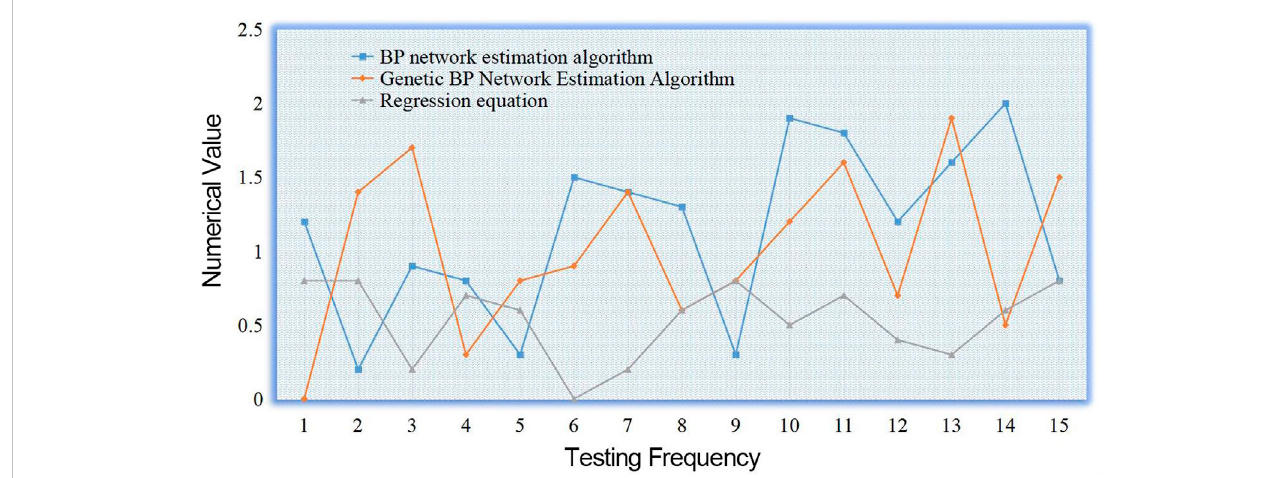
FIGURE 7 Error comparison chart of the algorithm.